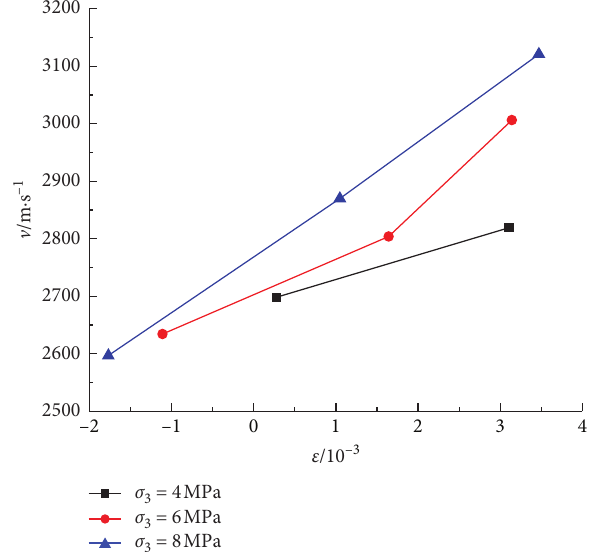
Figure 15: Relation of acoustic and volumetric strain under dif- ferent initial confining pressures.